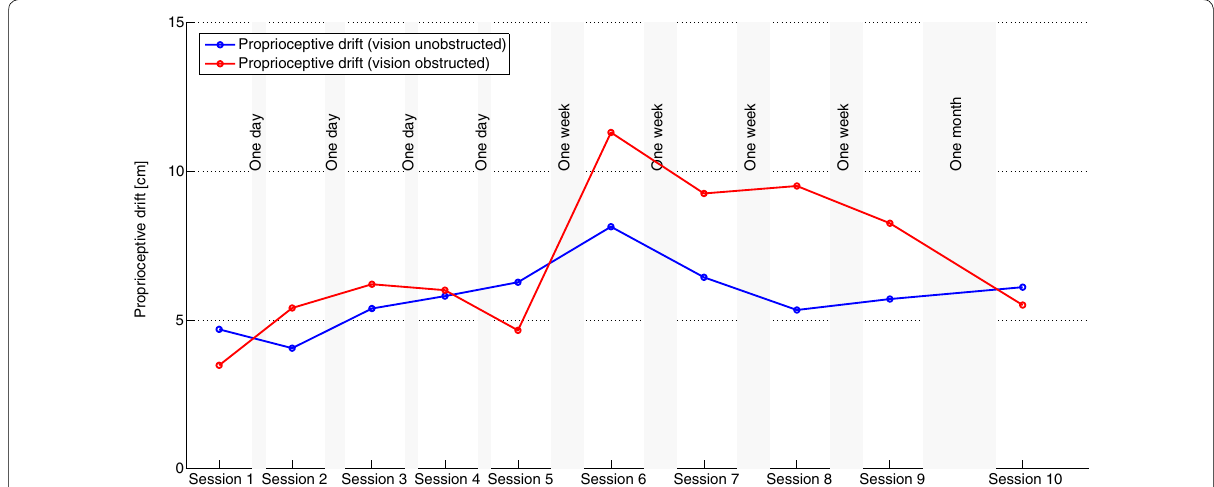
Fig. 9 Proprioceptive drift given by the difference between the distance of the pointed location where the subject believe their right thumb tip is located before and after each